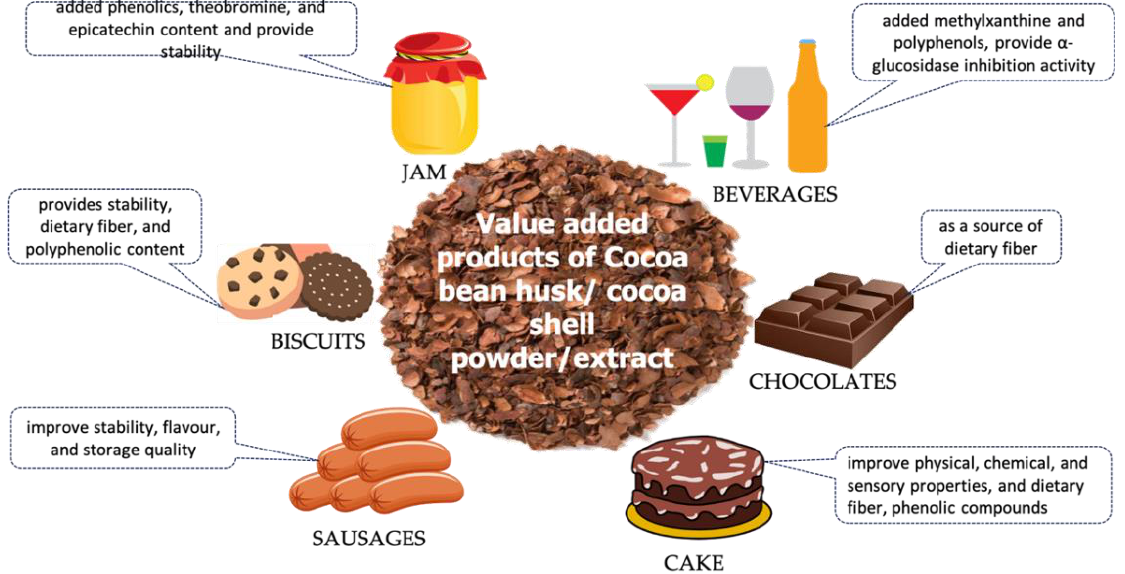
Figure 2. Valorization of food products with cocoa bean husk or cocoa shell extract.